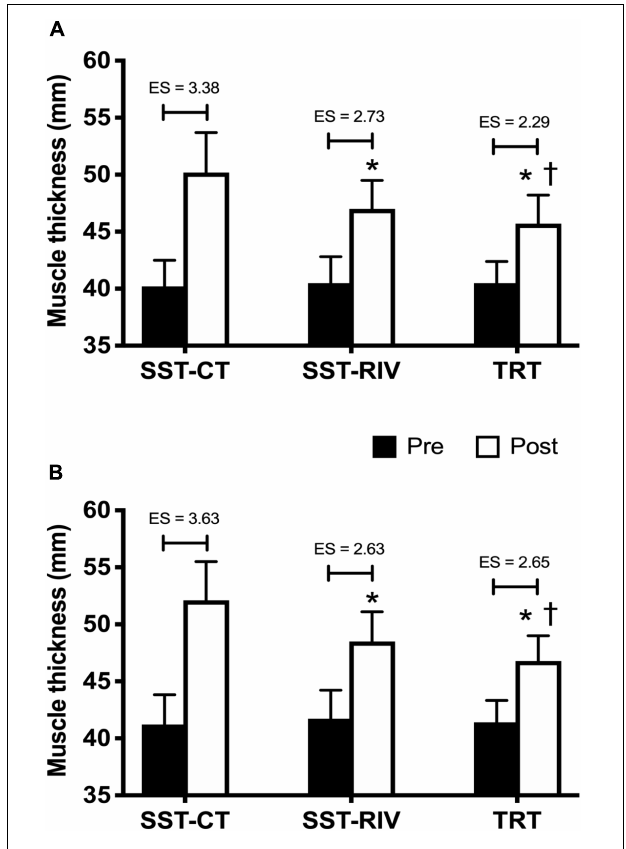
FIGURE 1 | Mean ± SD of biceps brachii (BB) (A) , and triceps brachii (TB) (B) pre- and post sarcoplasma stimulating training contraction type (SST-CT), SST rest interval variable (SST-RIV), and traditional resistance training (TRT) sessions. ES, effect size; ∗ p ≤ 0.05 for SST-CT after adjustment